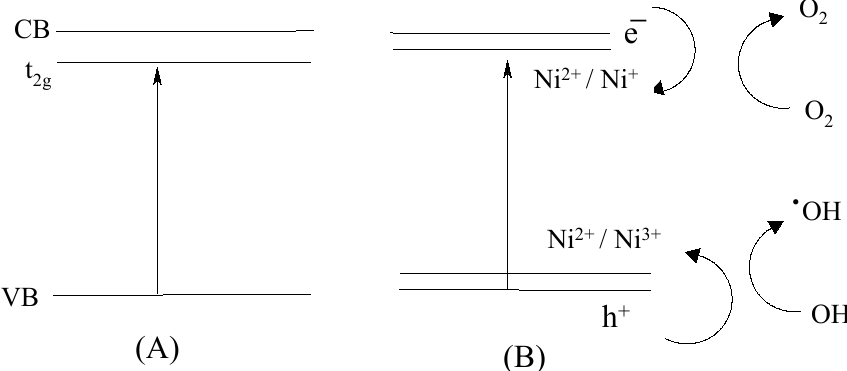
Figure 4. (A) Visible light activated Ni 2+ -TiO